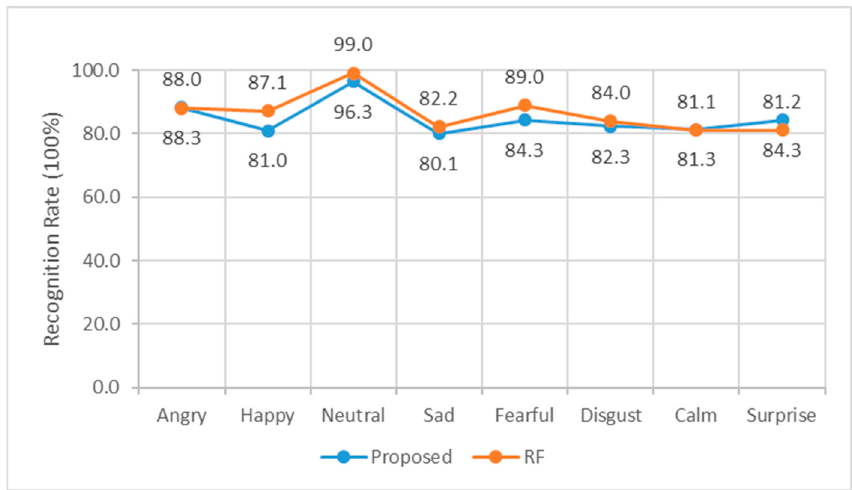
Figure 6. Emotion recognition rate obtained based on the proposed system and Random Forest Classi fi er using the RAVDESS dataset.